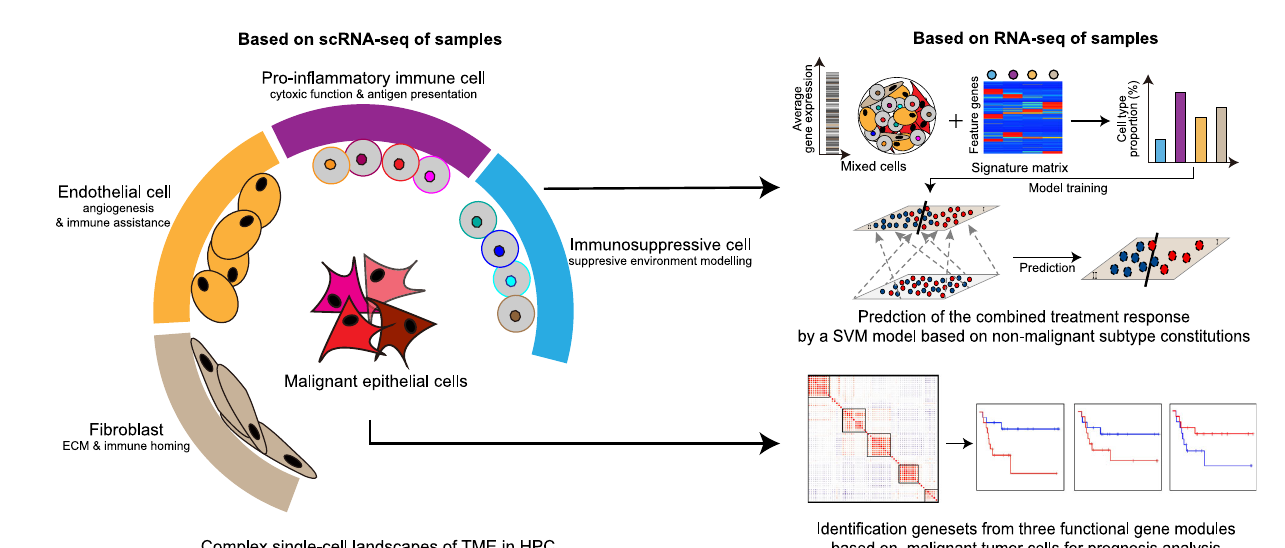
Fig. 6 | Prediction of the combined treatment response based on non- malignant subtype compositions. a Heatmap of the normalized cell abundance with fi fteen subtypes estimated via CIBERSORTx and clinical records in our HPC cohort.All44samplesfromRBT,NBT,RAT,andNATgroupsweredeconvolvedfor estimation. b Average cell compositions in TME among four groups by dividing fi fteen subtypes into twogroups named astumor-promoting subtypes and tumor- suppressive types. Error bars represent standard errors of cell constitutions in corresponding groups. The biological independent sample numbers in the four groups were 15, 15, 7, and 7, respectively. c Cartoon plot illustrating the processes forSVMconstructionfromourHPCcohortandapplicationforprospectivetrailsin HPC. d Measurement for the prediction performance of SVM classi fi er model. The area under receive operating characteristic curve is 0.86 on the training samples. e Heatmap of the normalized cell abundance with 15 subtypes for additional 12 samples. Tag of correct represented the labels from prediction model and true